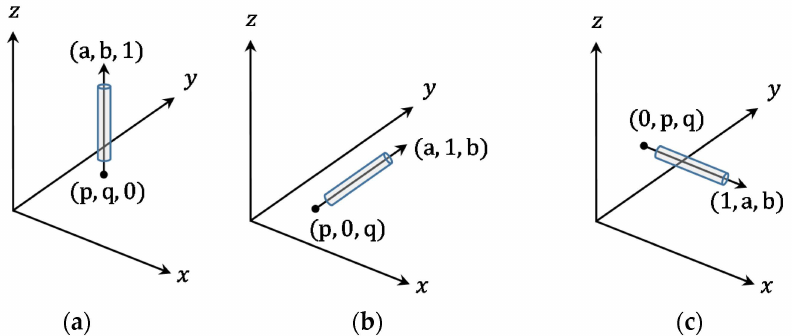
Figure 3. Representation scheme for 3D pole-like features; pole-like features that are almost parallel to the z ´ axis ( a ); pole-like features that are almost parallel to the y ´ axis ( b ); and pole-like features that are almost parallel to the x ´ axis ( c